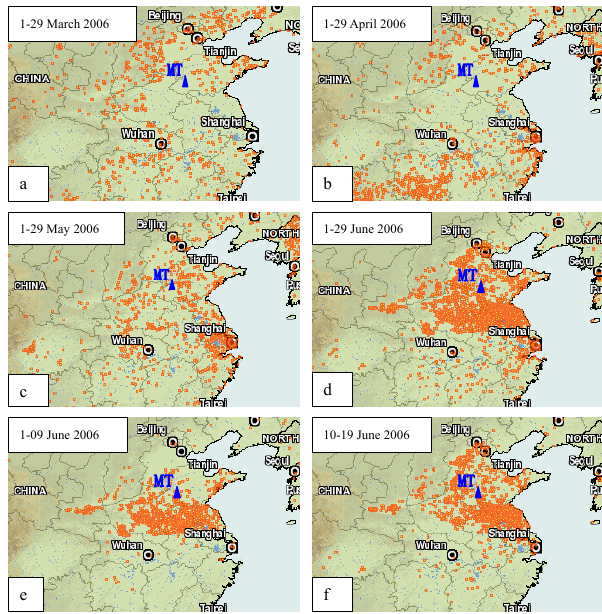
Fig. 7. Fire spot data derived from MODIS Global Fire Mapping during 2006: (a) 1–29 March, (b) 1–29 April, (c) 1–29 May, (d) 1–29 June, (e) 1–9 June and (f) 10–19 June at MT.